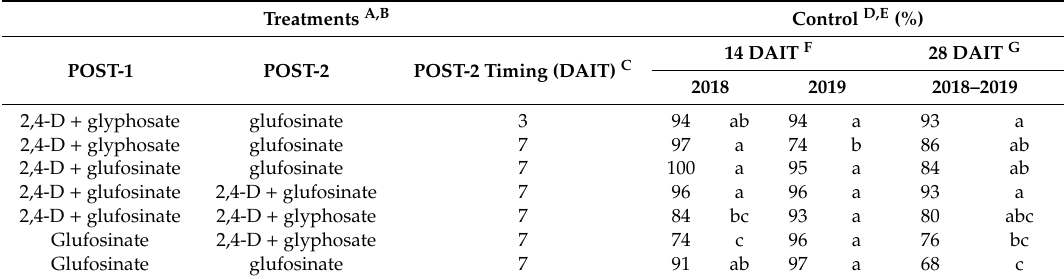
Table 2. Palmer amaranth control as a ff ected by sequential applications of 2,4-D and glufosinate in 2018 and 2019 field